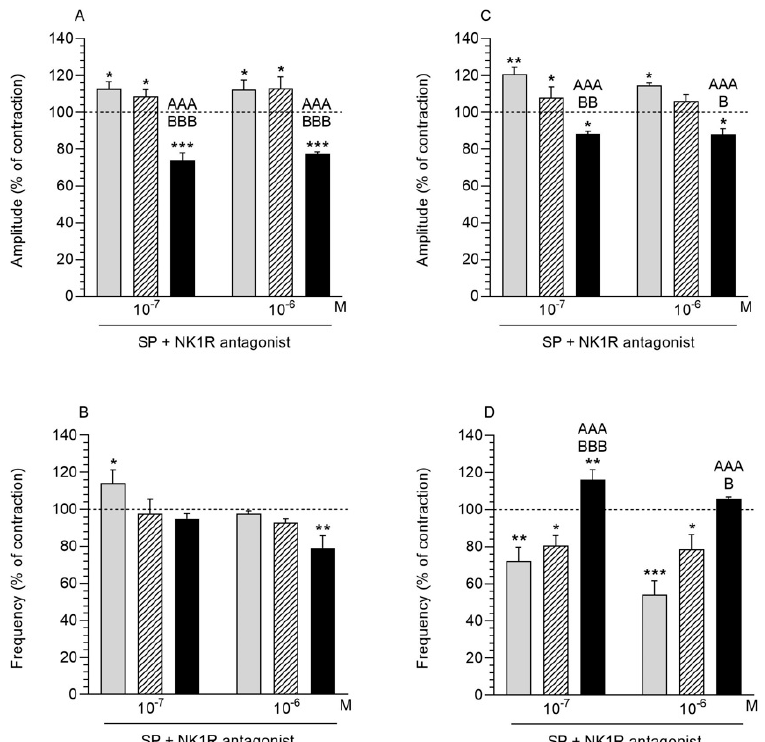
Figure 4. The influence of substance P (SP) on the contractile amplitude ( A , C ) and frequency ( B , D ) in the myometrium ( A , B ) and endometrium/myometrium ( C , D ) strips of gilts from the CON (grey bars), SAL (hatched bars) and E. coli (black bars) groups after using NK1R antagonist. Results were calculated for five gilts in each group. The effects of antagonist and individual SP doses are presented as percentages (mean ± SEM) of the baseline (pretreatment period) contractile amplitude and frequency, taken as 100% (horizontal lines). * p < 0.05, ** p < 0.01, *** p < 0.001 compared to the basal value in each group; AAA p < 0.001 compared between the CON and E. coli groups for the same treatment; B p < 0.05, BB p < 0.01, BBB p < 0.001 compared between the SAL and E. coli groups for the same